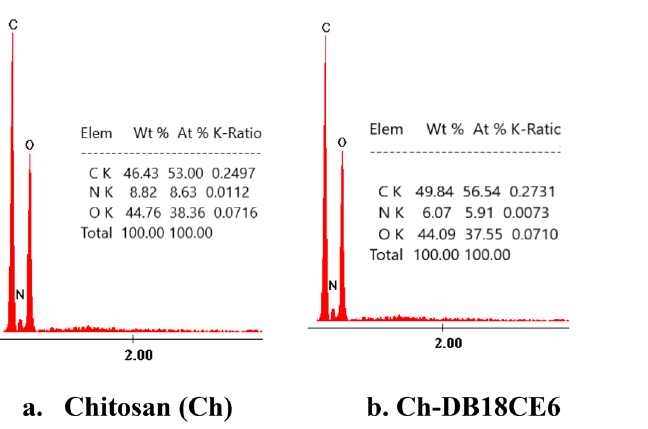
Figure 1. Scanning electron microscopy, SEM.